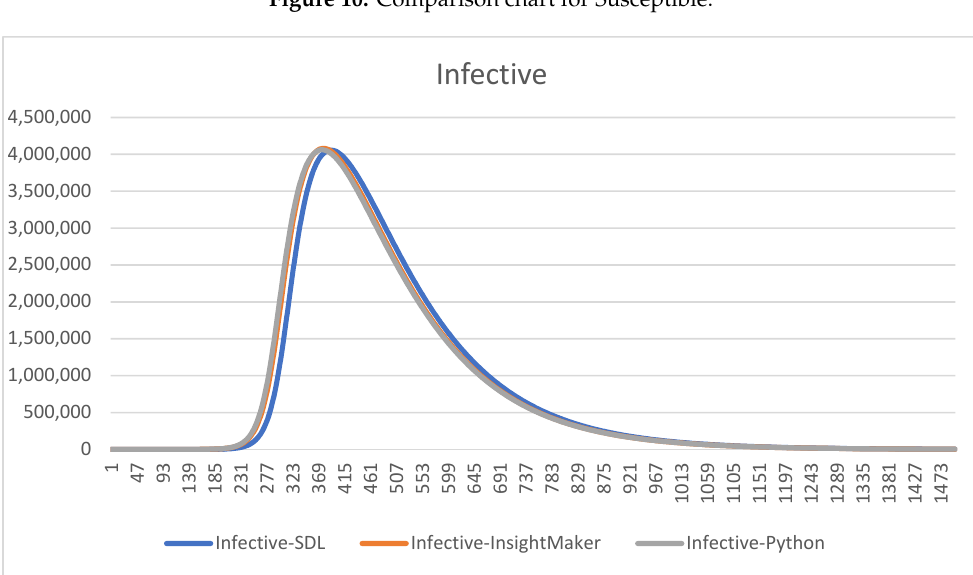
Figure 10. Comparison chart for Susceptible. Appl. Sci. 2020 , 10 , x FOR PEER REVIEW